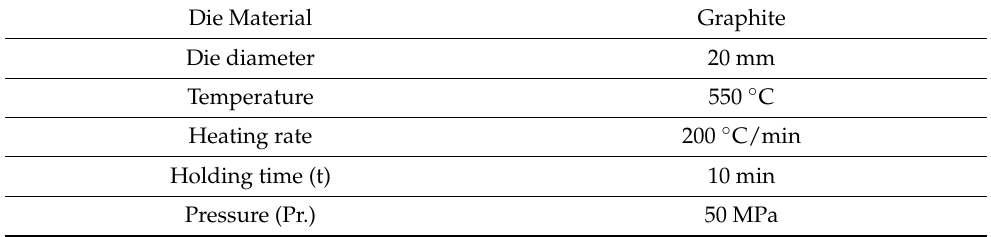
Table 1. Spark plasma sintering parameters used for fabricating the hybrid composite samples. Die Material